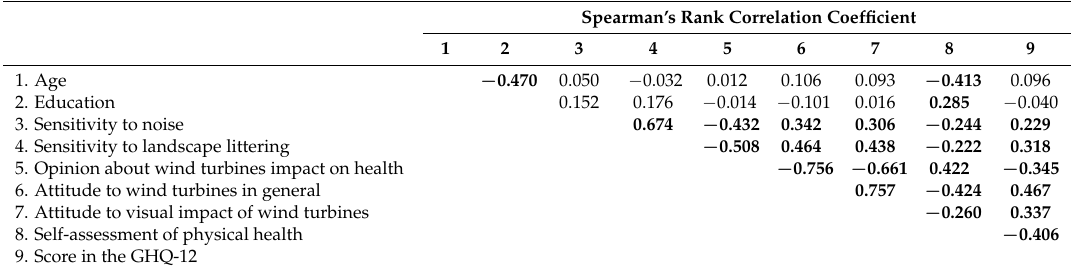
Table 3. Relationships between various subjective variables in the study group 1 . Statistically significant correlations are presented in bold numbers ( p <